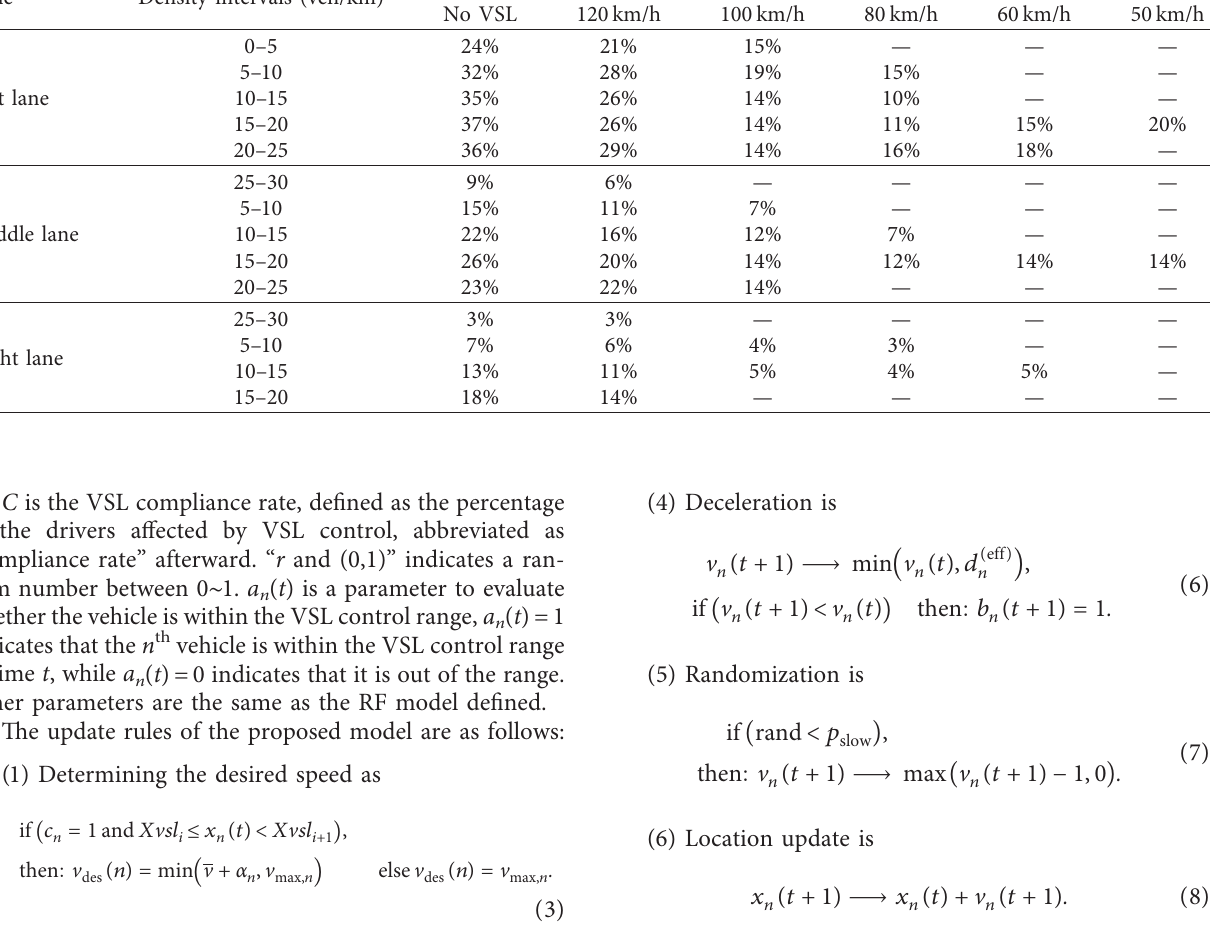
Table 2: Percentages of smaller than 1s headway within different density intervals under different speed limits.